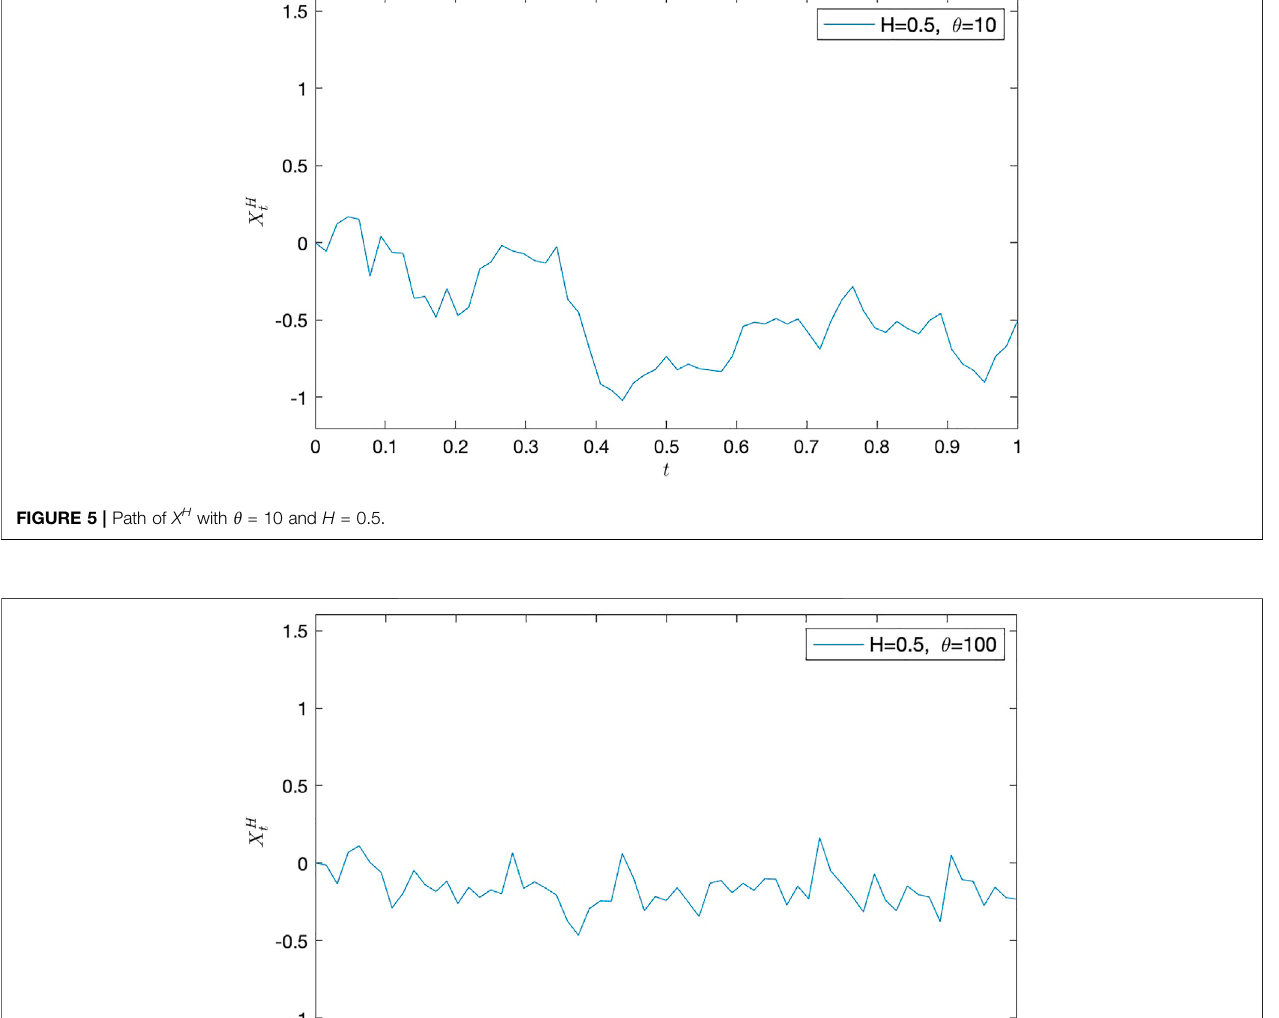
Frontiers in Physics |